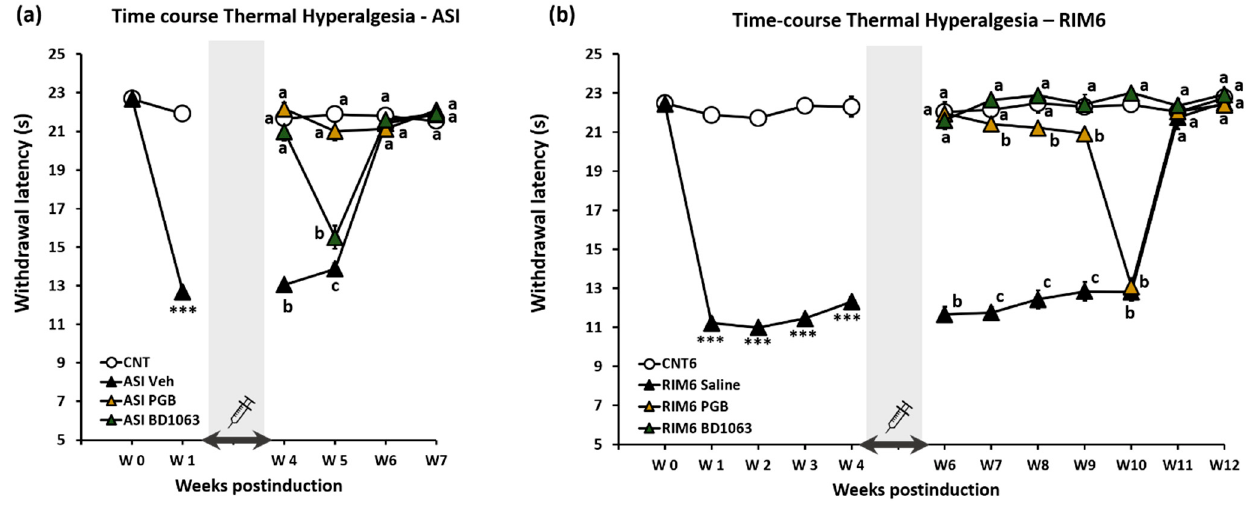
Figure 2. Effect of BD1063, pregabalin (PGB) and saline (vehicle) treatment on the thermal hyperalgesia response in the two experimental models of fibromyalgia. Withdrawal latency to painful thermal stimulus in the intramuscular acid saline solution injection model ( a ) and the reserpine-induced myalgia model ( b ). The shaded bar and the syringe indicate the postinduction period in which pharmacological treatments were administered. *** p < 0.001 with respect to the control group. a–c: Groups not sharing a letter are significantly different, p < 0.05. Each point and vertical line represent the mean ± SEM.